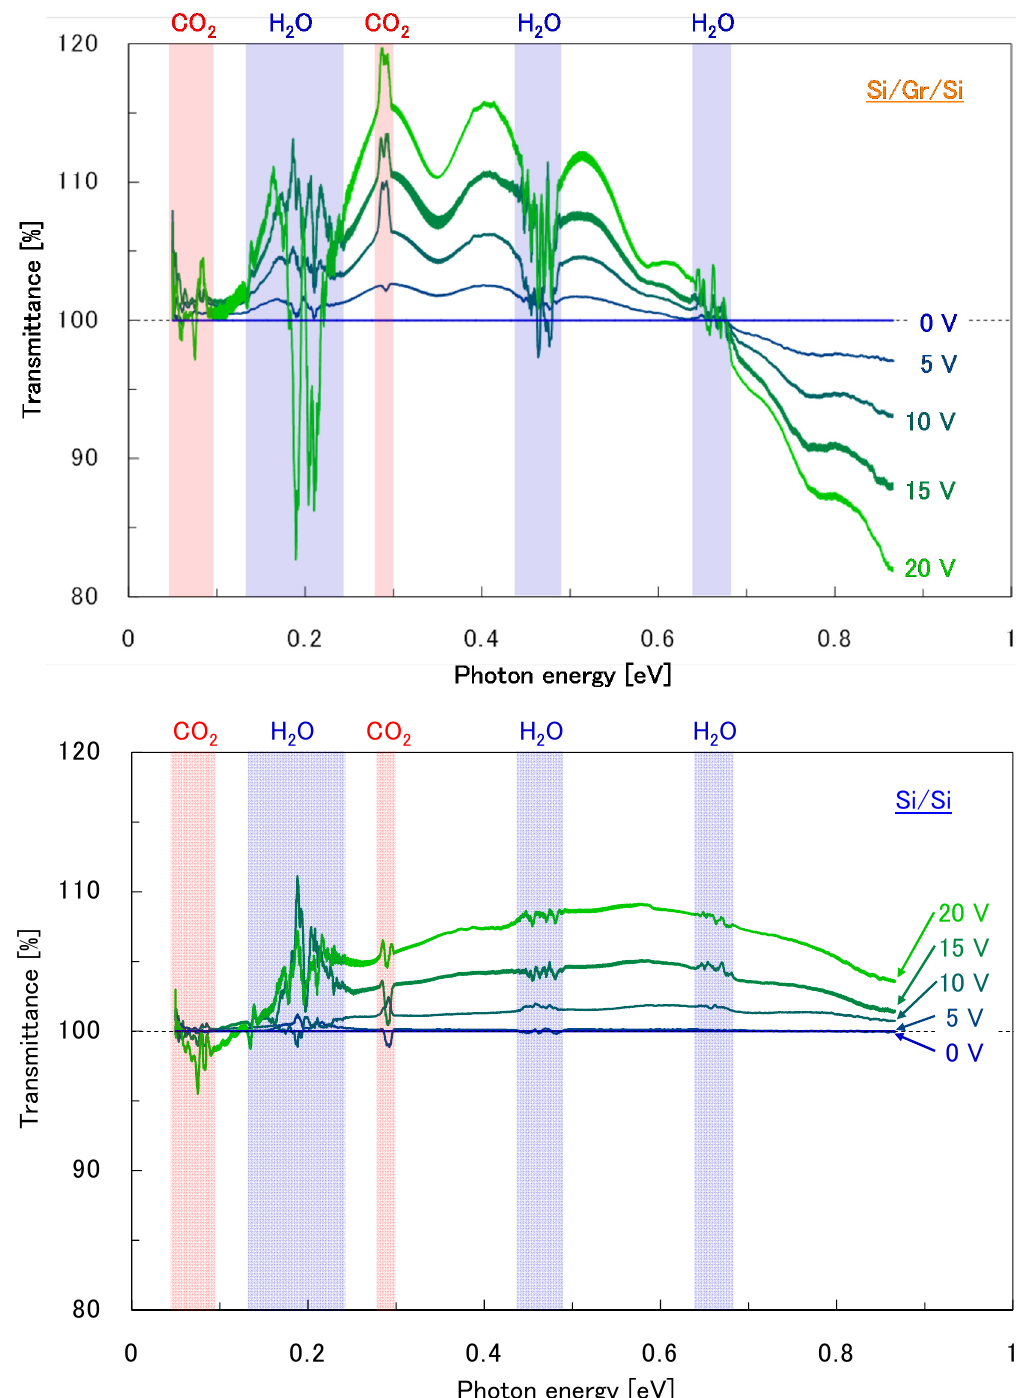
Figure 8. FTIR transmission spectra with applied electrical bias for ( top ) the Si/bilayer graphene/Si double heterostructure and ( bottom ) the Si/Si control sample. The regions highlighted in blue and red contain noise originating from ambient concentration changes in H 2 O and CO 2 , respectively.